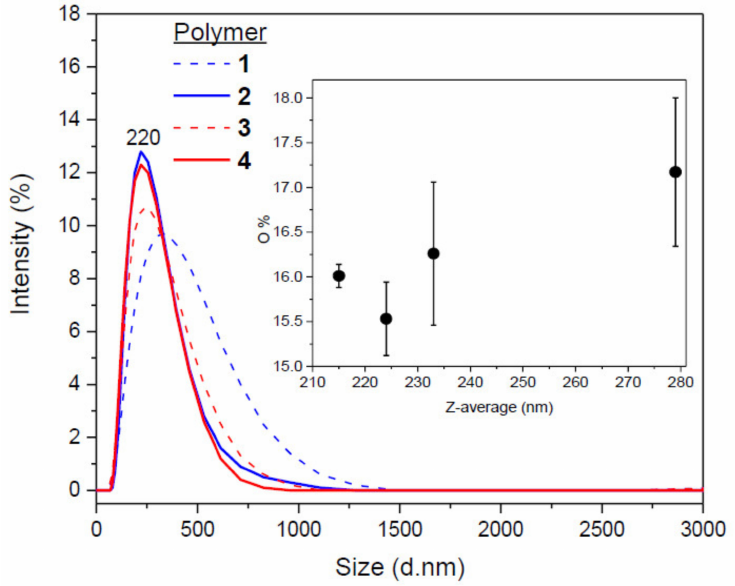
Figure 5. Size distributions of the particles from polymers 1 – 4 measured by DLS. In the in- sert plot, the relationship between the Z-average and the oxygen content in the corresponding samples is represented. Table 3. Morphological and textural characteristics and other physical properties of the